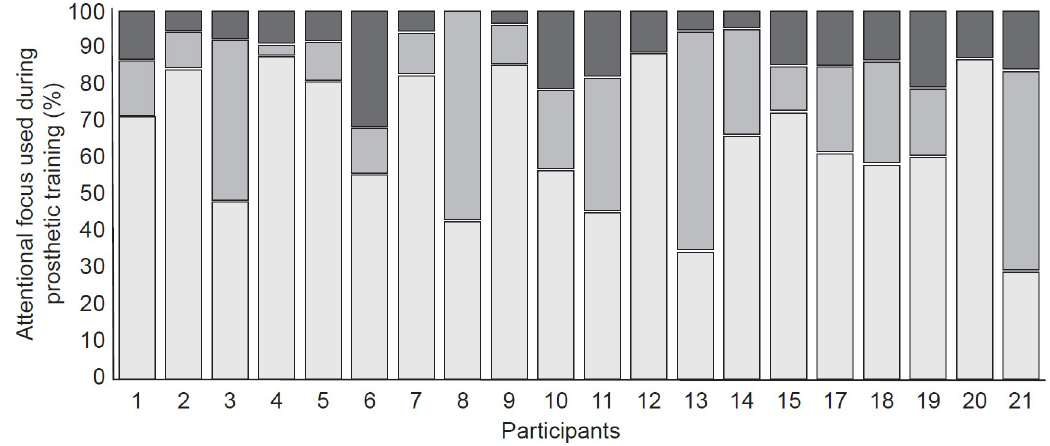
Fig 1. Distribution of external and internal focus instruction and feedback during prosthetic training (dark gray = % external focus, medium gray = % internal focus on intact body, and light gray = % internal focus on prosthesis).